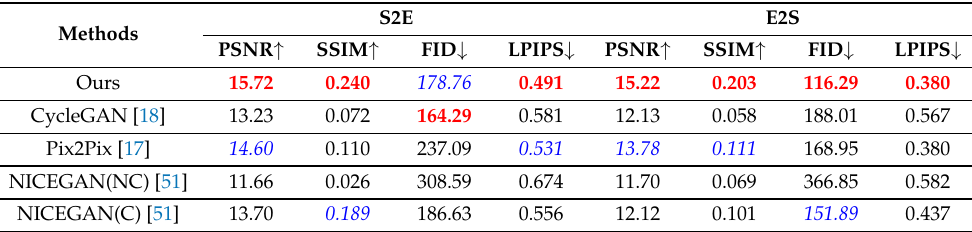
Table 2. Comparisons of IQA scores on SAR2Opt for S2E (SAR to EO) and E2S (EO to SAR) tasks. The best and second best results are highlighted as red bold and blue italic , respectively.